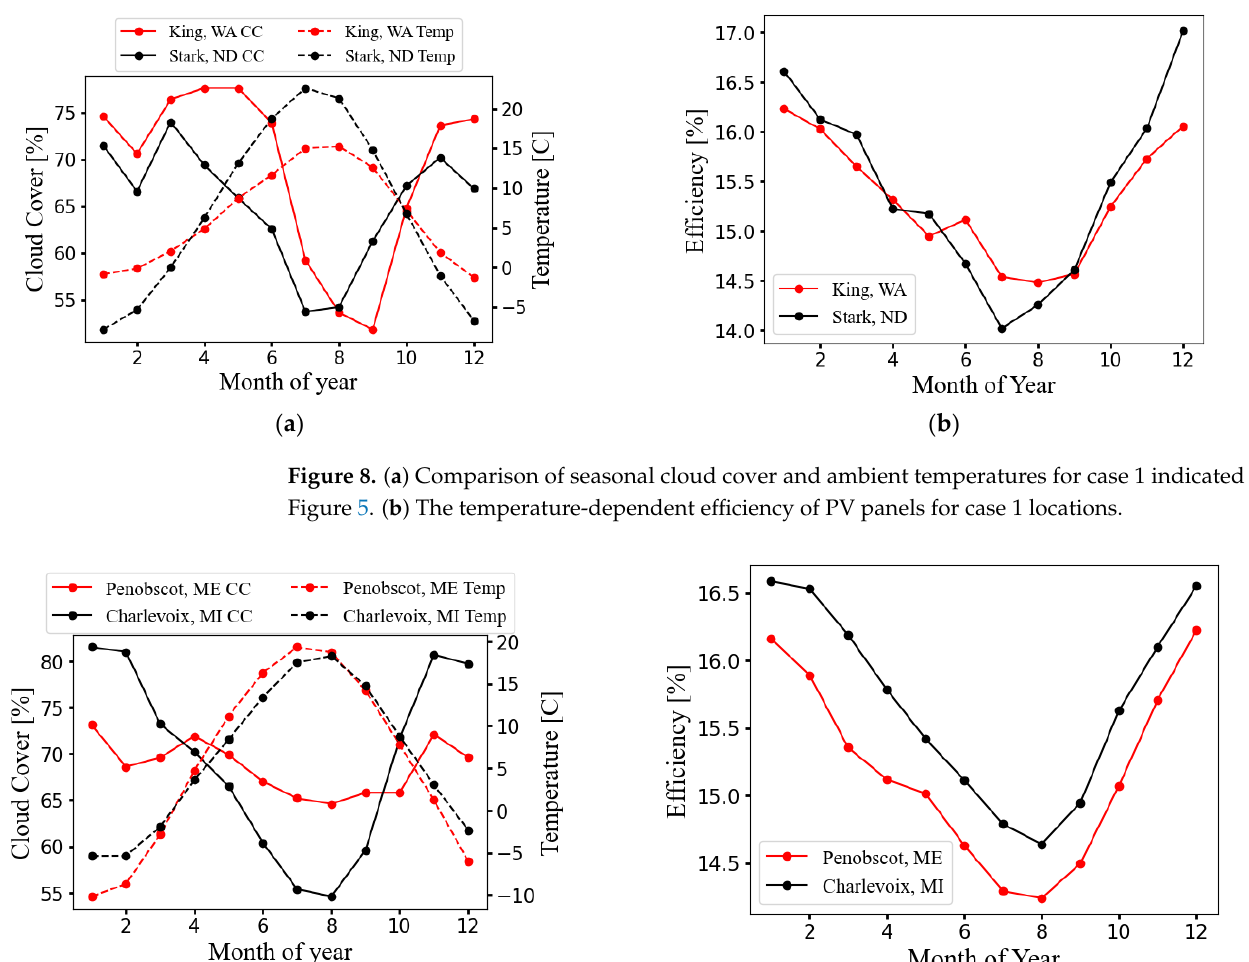
Figure 7. Daylight hours for three different latitudes as a function of month of the year.